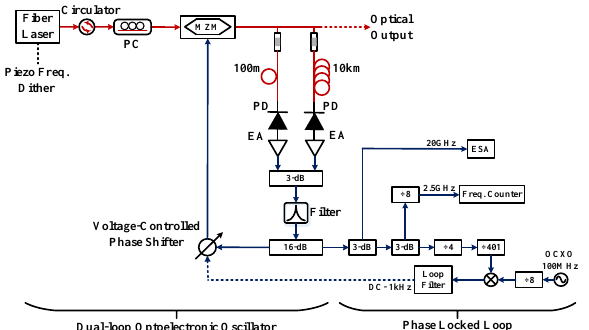
Figure 14. The schematic diagram of the phase-locked loop architecture utilizing OEO as a voltage-controlled oscillator (VCO). MZM: Mach-Zehnder modulator. PC: polarization controller. PD: photodetector. EA: electrical amplifier. ESA: electrical spectrum analyzer. Reprinted with permission from Ref. [51], IEEE, 2018 .